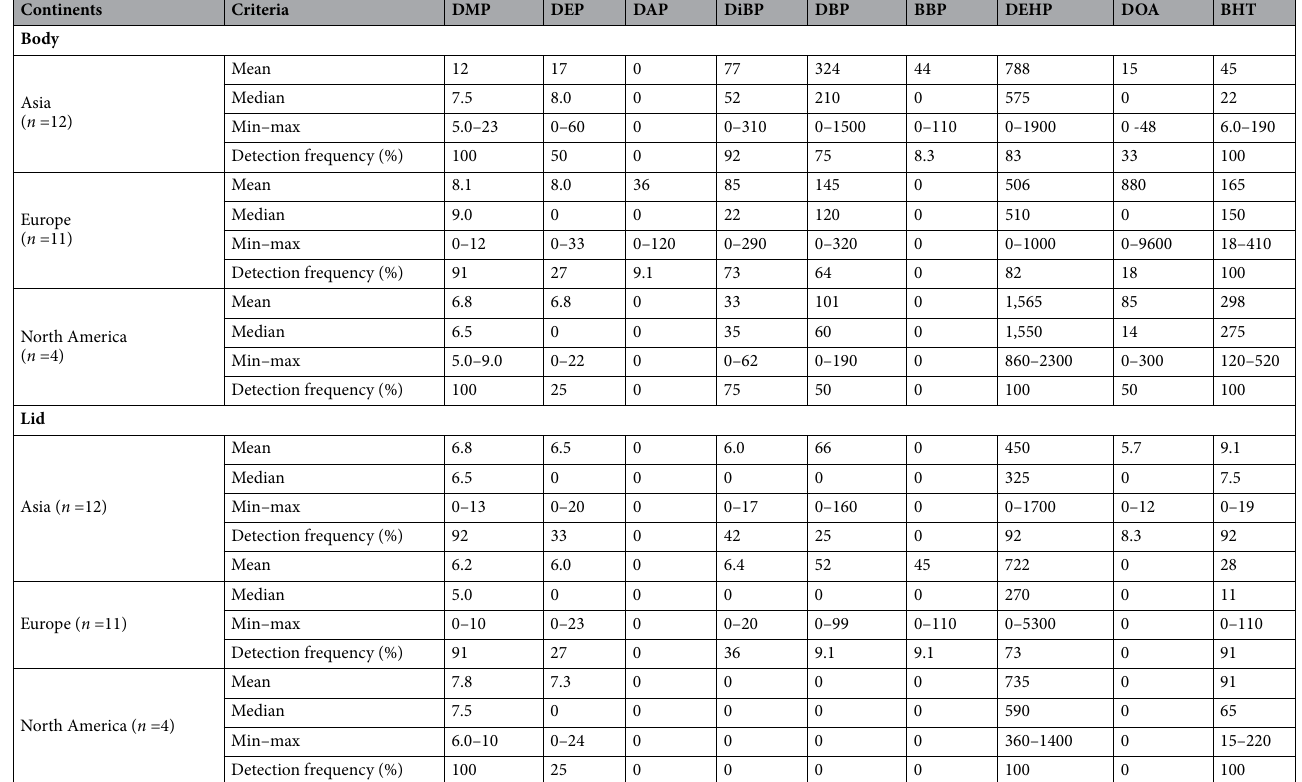
Table 2. Plastic additives concentration (ng/g) by continents in beer cans. DMP dimethyl phthalate, DEP diethyl phthalate, DAP diallyl phthalate, DiBP diisobutyl phthalate, DBP dibutyl phthalate, BBP benzyl butyl